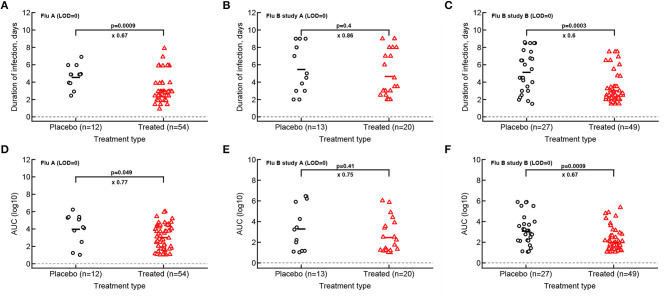
Impact of oseltamivir treatment on the duration of infection and the overall viral shedding depends on the study. For every volunteer in 3 clinical trials we calculated the duration of infection (A–C) or the overall shedding defined as AUC (see section 2 for detail) for Flu A (A,D), Flu B study A (B,E), or Flu B study B (C,F) data. Horizontal lines indicate median values. The number of volunteers, n, analyzed in each of the trial and tests is shown on the x-axis of each graph. Comparisons between groups done using Mann–Whitney test, magnitude of the effect is indicated as × fold change, and p values from the test are shown on individual panels.